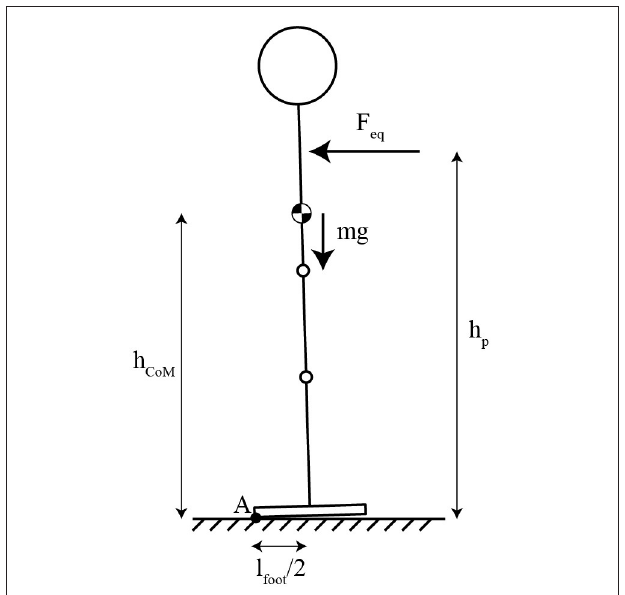
FIGURE 7 | Equivalent system for the static balance calculation with flat